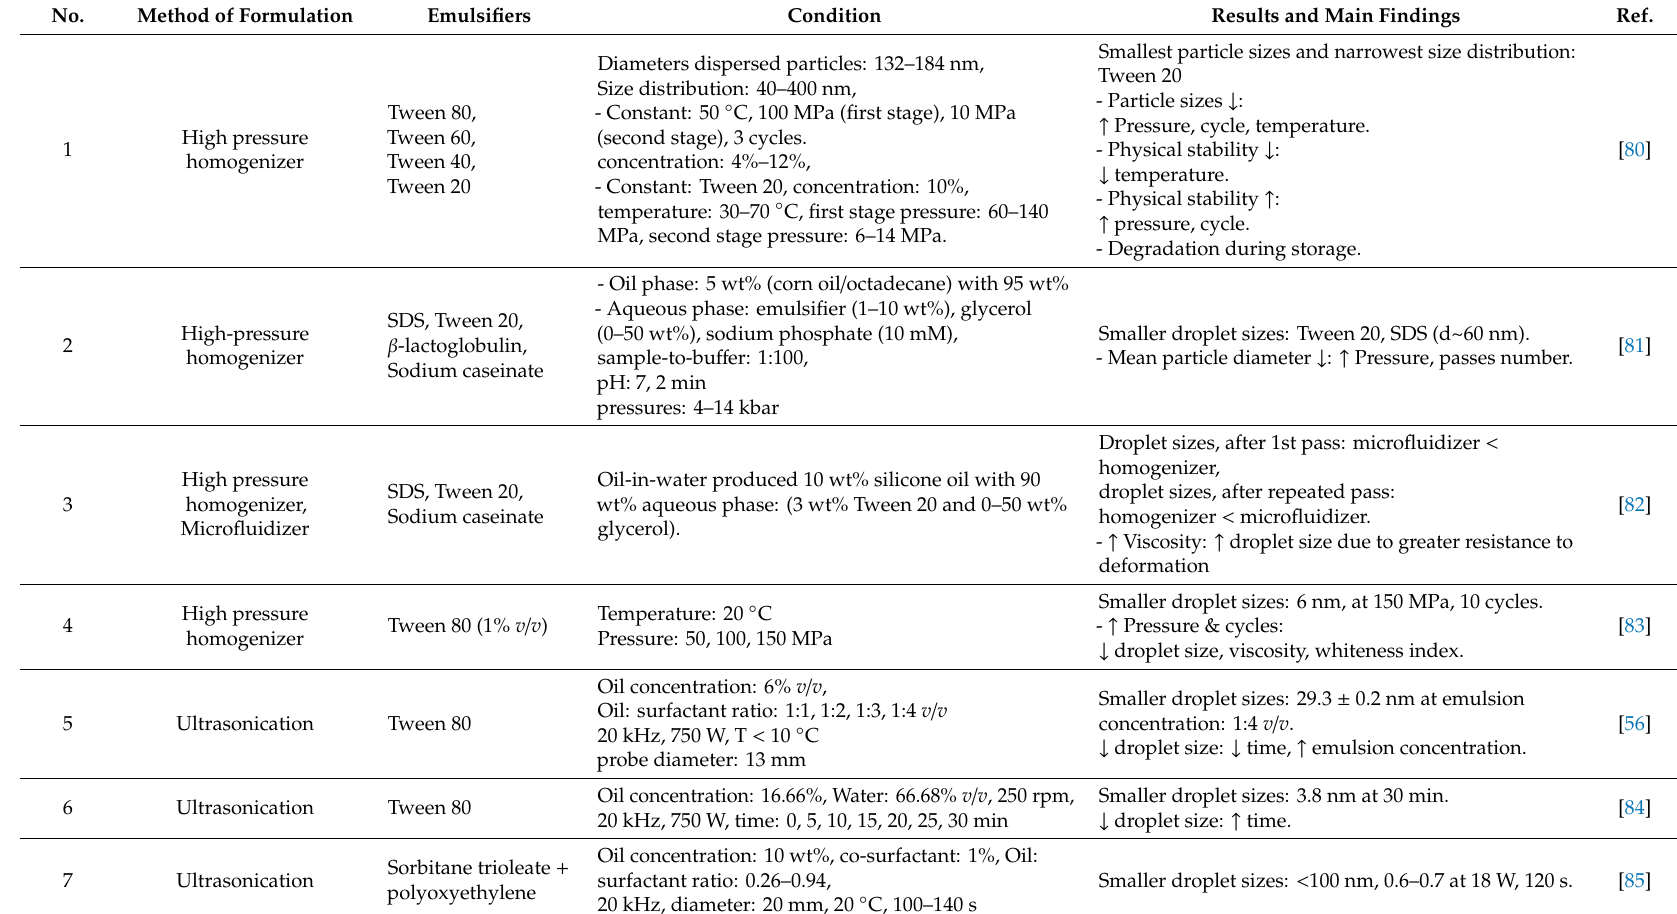
Table 2. The di ff erent methods of NEs formulation based on low and high energy